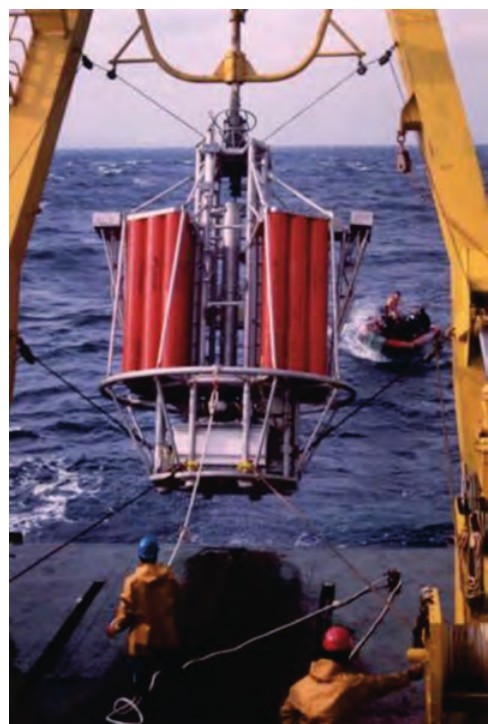
Fig. 3. NADIA being put in sea